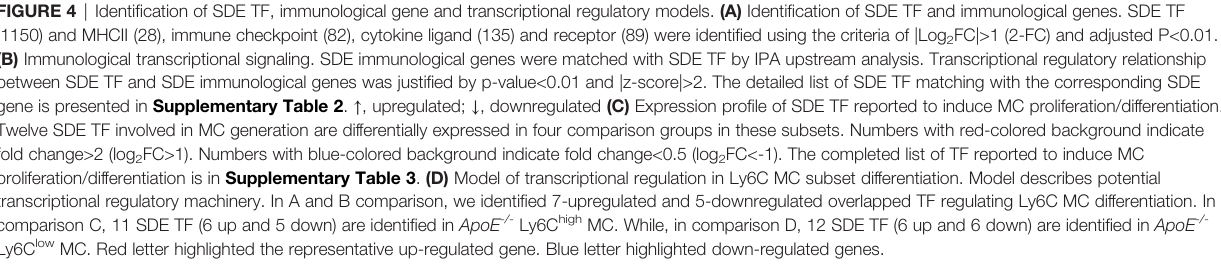
FIGURE 4 | Identi fi cation of SDE TF, immunological gene and transcriptional regulatory models. (A) Identi fi cation of SDE TF and immunological genes. SDE TF (1150) and MHCII (28), immune checkpoint (82), cytokine ligand (135) and receptor (89) were identi fi ed using the criteria of |Log 2 FC|>1 (2-FC) and adjusted P<0.01. (B) Immunological transcriptional signaling. SDE immunological genes were matched with SDE TF by IPA upstream analysis. Transcriptional regulatory relationship between SDE TF and SDE immunological genes was justi fi ed by p-value<0.01 and |z-score|>2. The detailed list of SDE TF matching with the corresponding SDE gene is presented in Supplementary Table 2 . ↑ , upregulated; ↓ , downregulated (C) Expression pro fi le of SDE TF reported to induce MC proliferation/differentiation. Twelve SDE TF involved in MC generation are differentially expressed in four comparison groups in these subsets. Numbers with red-colored background indicate fold change>2 (log 2 FC>1). Numbers with blue-colored background indicate fold change<0.5 (log 2 FC<-1). The completed list of TF reported to induce MC proliferation/differentiation is in Supplementary Table 3 . (D) Model of transcriptional regulation in Ly6C MC subset differentiation. Model describes potential transcriptional regulatory machinery. In A and B comparison, we identi fi ed 7-upregulated and 5-downregulated overlapped TF regulating Ly6C MC differentiation. In comparison C, 11 SDE TF (6 up and 5 down) are identi fi ed in ApoE -/- Ly6C high MC. While, in comparison D, 12 SDE TF (6 up and 6 down) are identi fi ed in ApoE -/- Ly6C low MC. Red letter highlighted the representative up-regulated gene. Blue letter highlighted